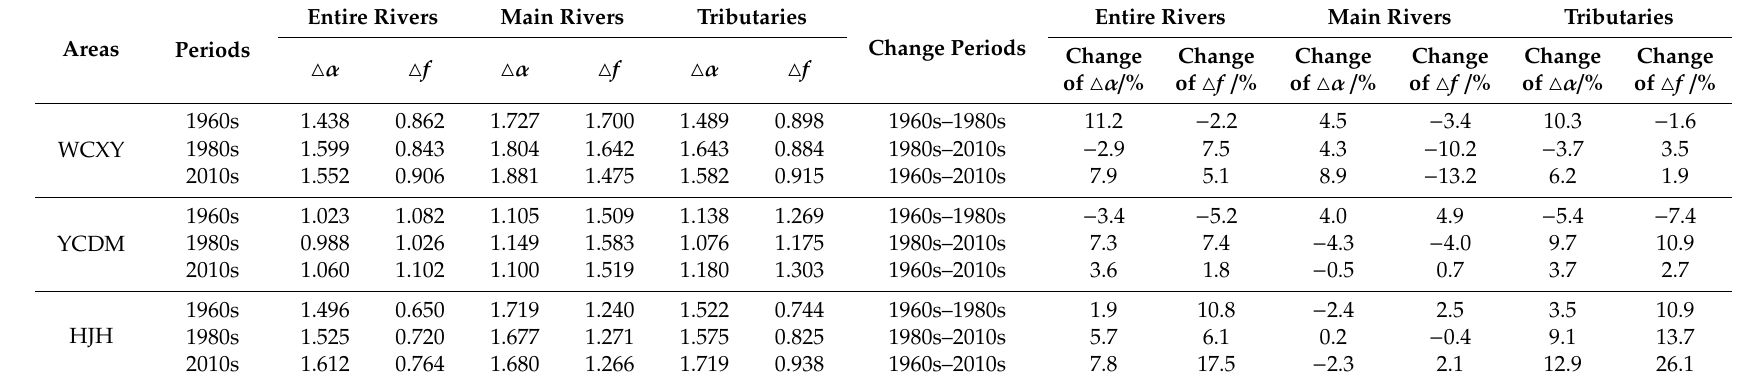
Table 3. Multifractal features of the Main Rivers (1st and 2nd order) and Tributaries (3rd and 4th order) in studied periods.